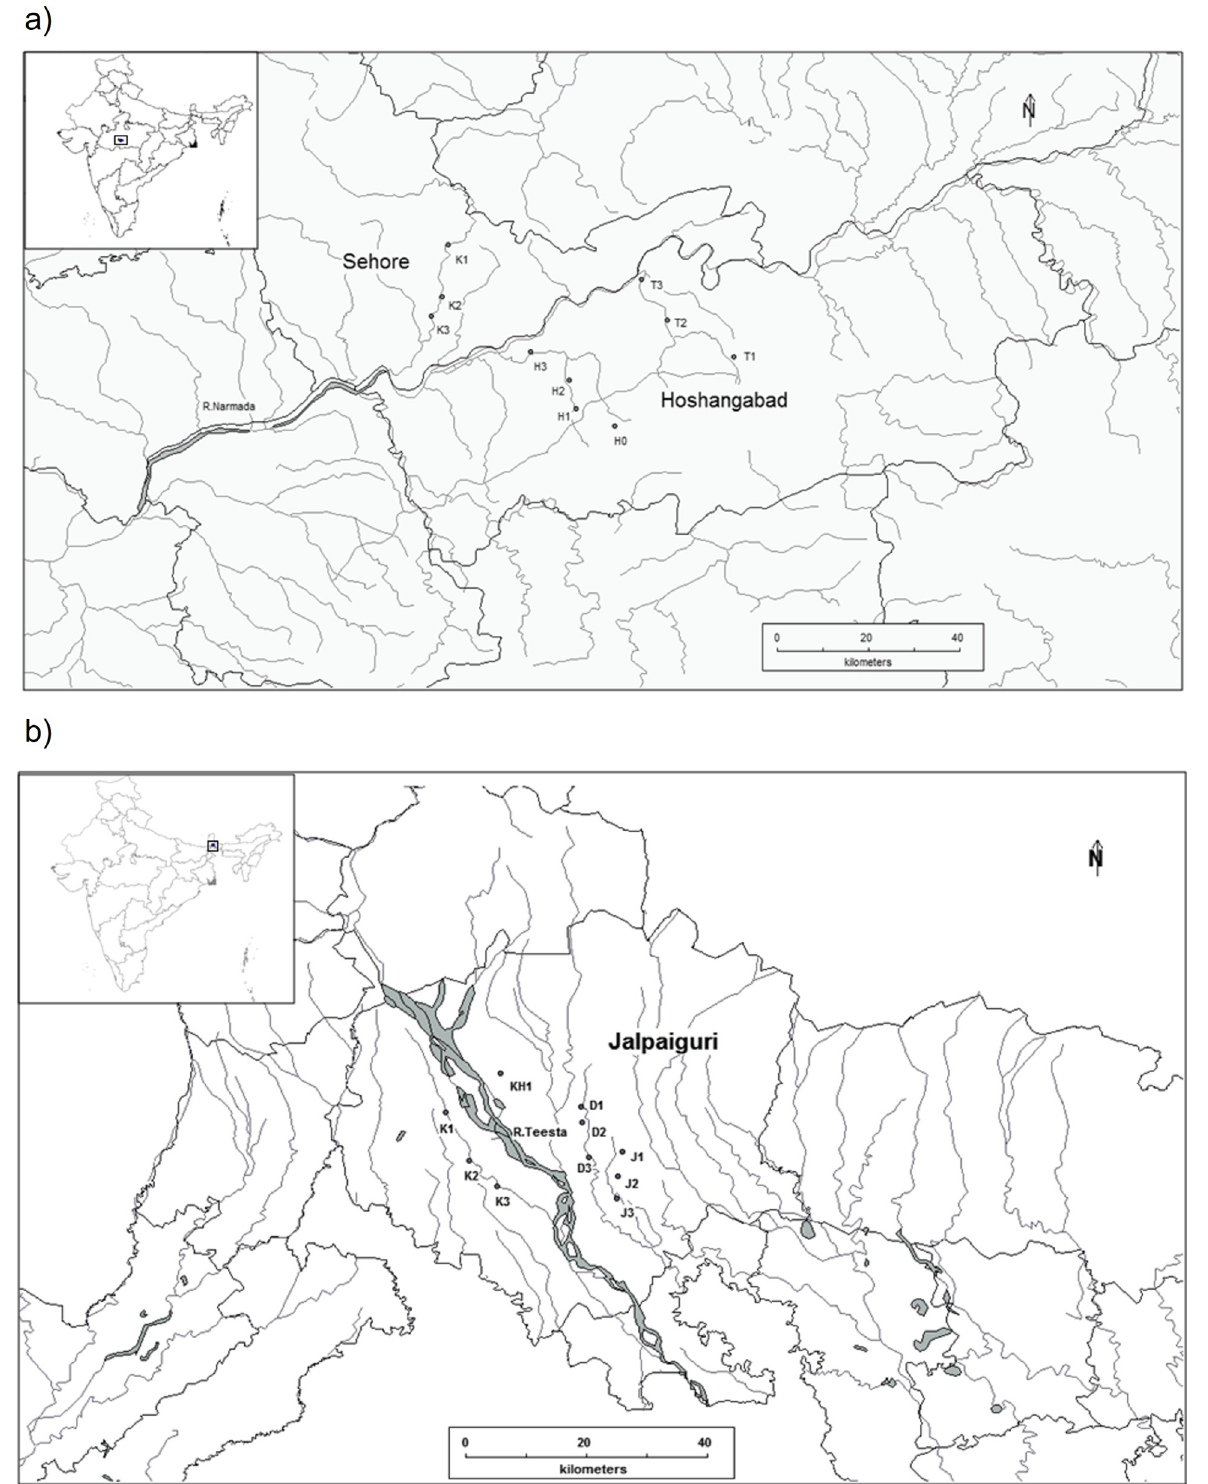
Fig 1. Location of sampling sites in the study regions. a) Sampling sites in Madhya Pradesh, depicted by alphabets for the river name and ascending numbers depicting upstream to downstream. b) Sampling sites in West Bengal, depicted by alphabets for the river names and ascending numbers depicting upstream to downstream. Further details in Tables 1 and